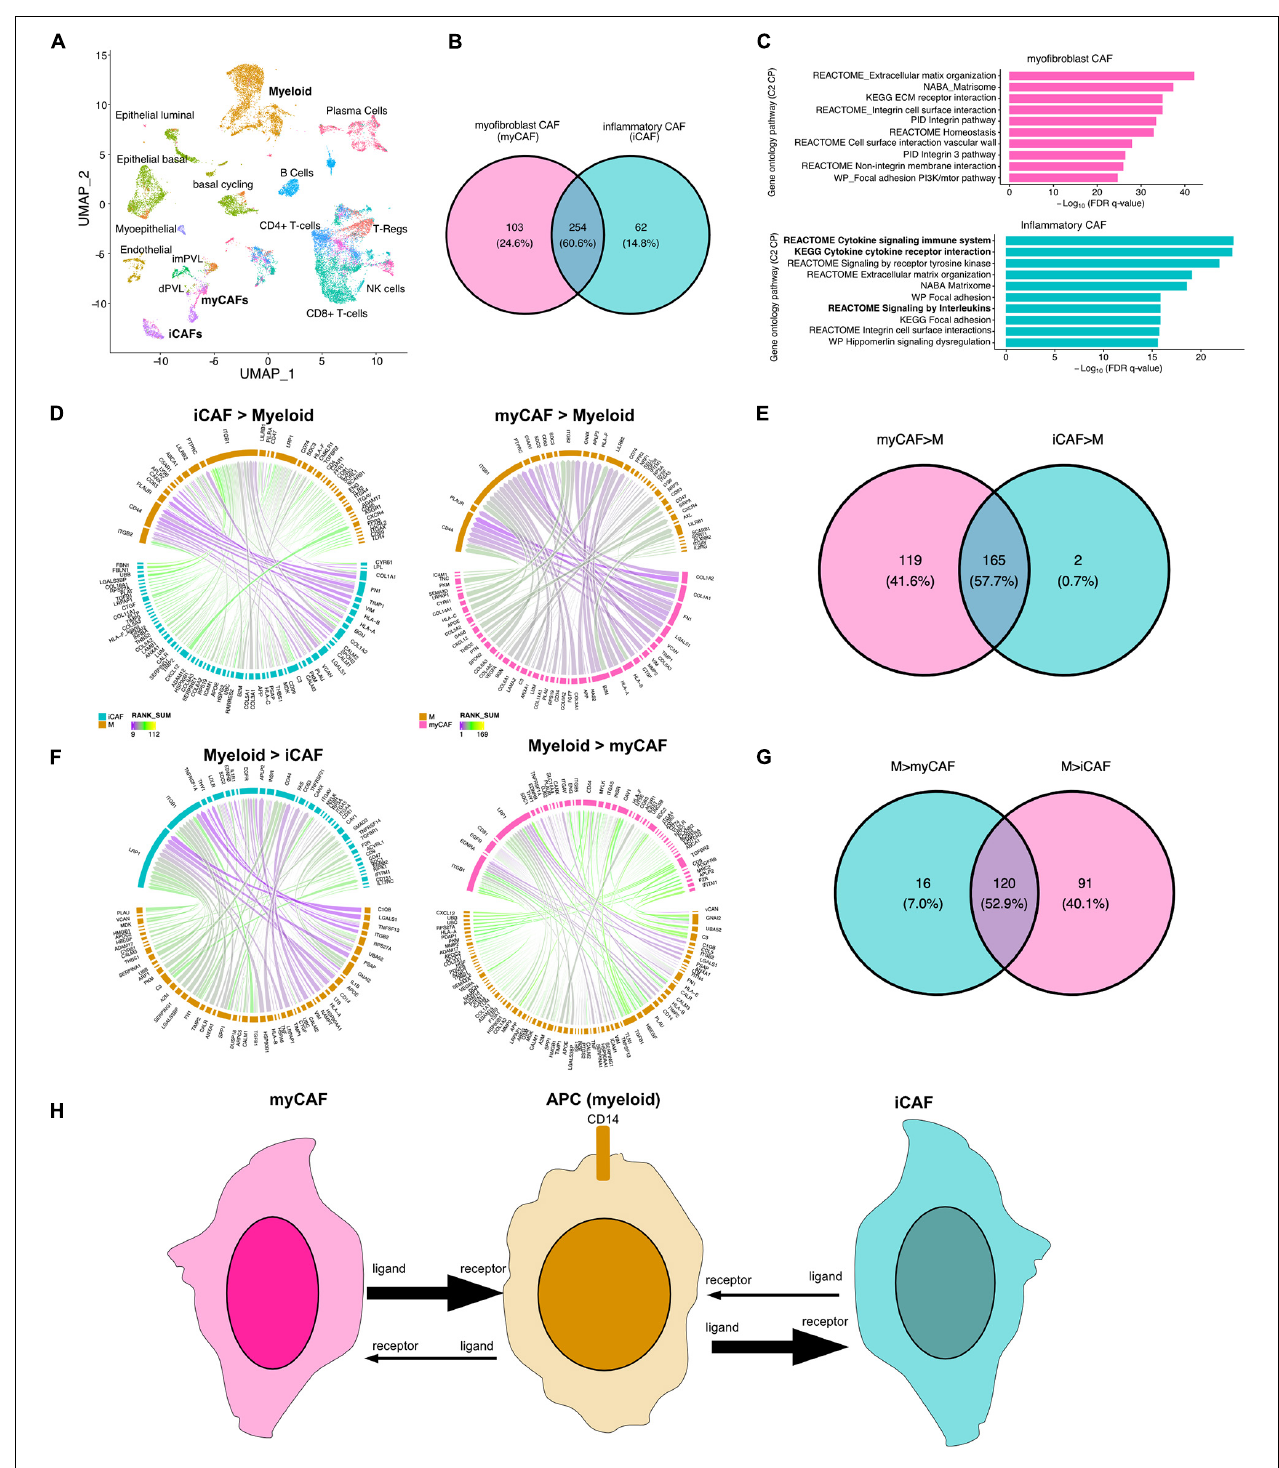
FIGURE 4 | Direction of LR interactions favor myofibroblast CAFs to myeloid and myeloid to inflammatory CAFs. (A) UMAP plot shows distinct cell populations in five TNBC tumors with cells of interest in bold. (B) Venn diagram of interactions between myeloid and myCAF with interaction between myeloid and iCAF. (C) Gene ontology pathway analysis (C2 canonical pathways) of differential interactions unique to myCAFs (pink) or iCAFs (blue). (D) Circos plots show the top interactions between iCAF and myeloid cells (iCAF > myeloid) or myCAF to myeloid (myCAF > myeloid). (E) Venn diagram shows overlap of interactions between CAFs and myeloid cells. (F) Circos plots show the top interactions between myeloid cells and iCAFs (iCAF > myeloid) or myCAFs (myCAF > myeloid). (G) Venn diagram shows overlap of interactions between myeloid to CAF interactions. (H) Summary of directional interactions between myeloid cells and myCAFs or iCAFs.